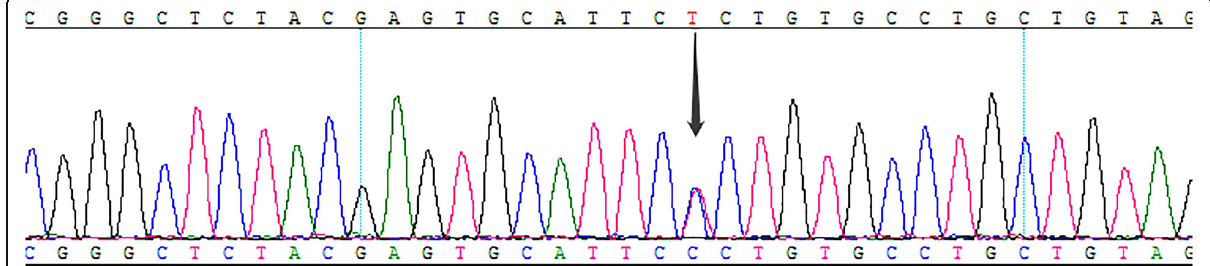
Fig. 2 The novel variant of the SDHB gene: Genomic DNA analysis of peripheral blood leukocytes, showing a germline missense mutation in exon 6 of the SDHB gene [c.563 T > C]